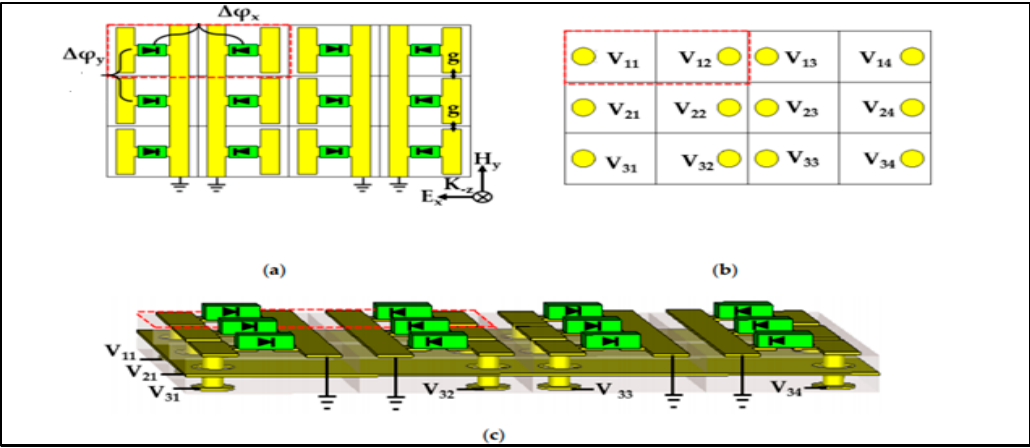
Figure 5. MS structure with varactor DC biasing method. ( a ) MS top layer. ( b ) MS back layer with varactors’ DC bias indexes. ( c ) 3D inside view of the MS with the closure of the electrical circuit for each varactor [8].